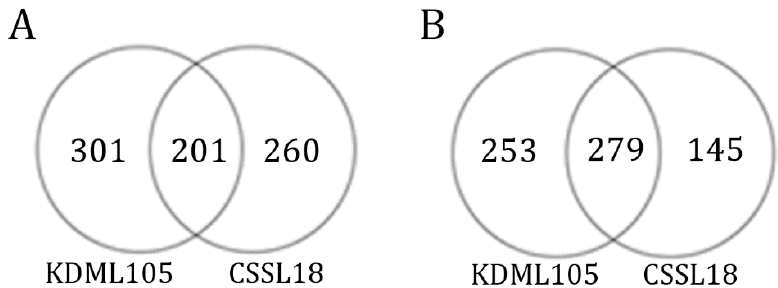
Figure 4. Salt injury scores for CSSL18, ‘KDML105’, and ‘Pokkali’ rice seedlings treated with 75 mM NaCl as a check for the transcriptomic study of CSSL18 and ‘KDML105’ . The different lower case letters show the significant difference of means, p < 0 . 05. Figure 5. Numbers of significantly differentially expressed genes in response to salt stress . ( A ) Numbers of upregulated genes; ( B ) numbers of downregulated genes .